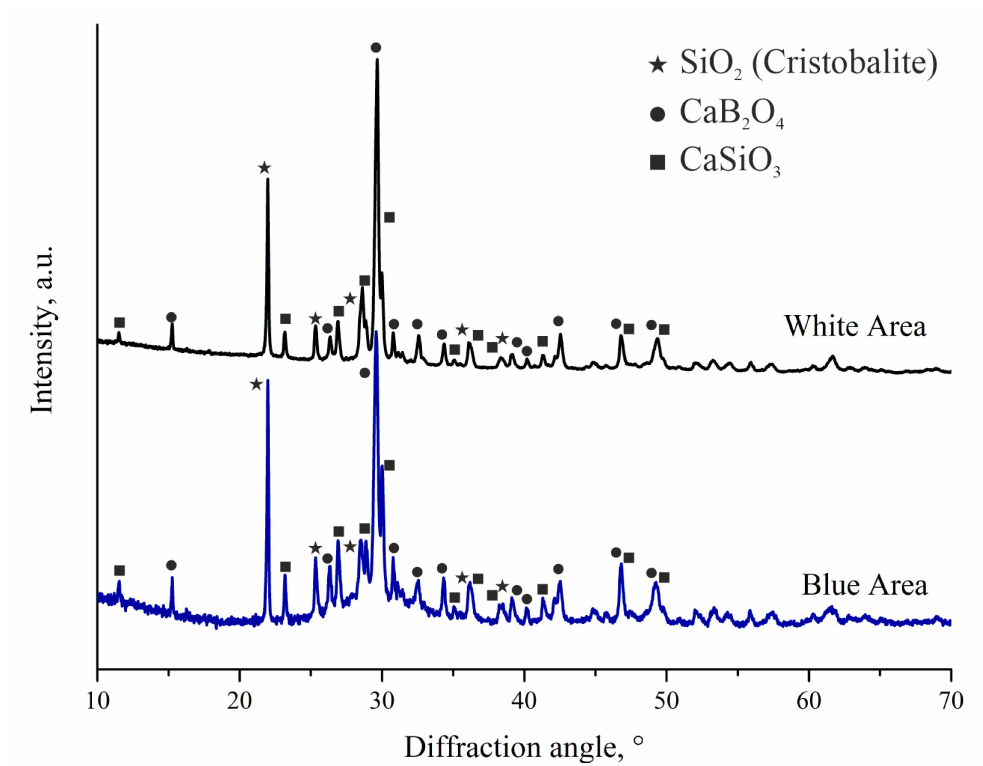
Figure 4. XRD patterns of white and blue areas of the CaO-SiO 2 -B 2 O 3 after heat treatment at 925 ◦ C. Symbols mark positions of the most intensive peaks of different